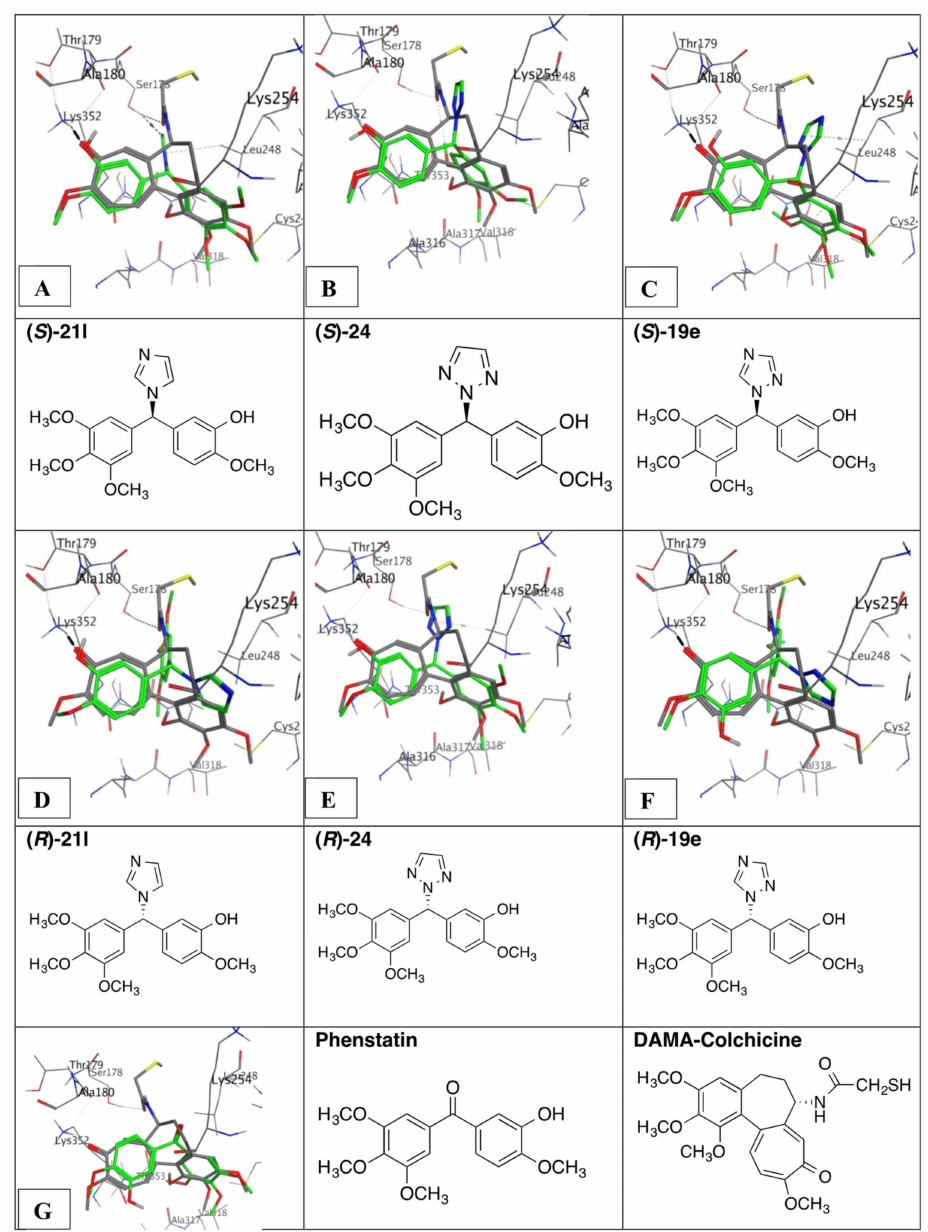
Figure 13. Docking of compounds 19e , 21l , and 24 in the colchicine binding site of tubulin. Overlay of the X-ray structure of tubulin co-crystallised with DAMA-colchicine (PDB entry 1SA0) on the best-ranked docked poses of the three S enantiomers ( A ) 21l, ( B ) 24 , and ( C ) 19e . Overlay of the X-ray structure of tubulin co-crystallised with DAMA-colchicine (PDB entry 1SA0) on the best ranked docked poses of the three R enantiomers ( D ) 21l , ( E ) 24 , ( F ) 19e , and ( G ) Phenstatin ( 7a ). Ligands are rendered as tube and amino acids as a line. Tubulin amino acids and DAMA-colchicine are coloured by atom type; the three heterocycles are coloured green. The atoms are coloured by element type, carbon = grey, hydrogen = white, oxygen = red, nitrogen = blue, sulphur = yellow. Key amino acid residues are labelled, and multiple residues are hidden to enable a clearer